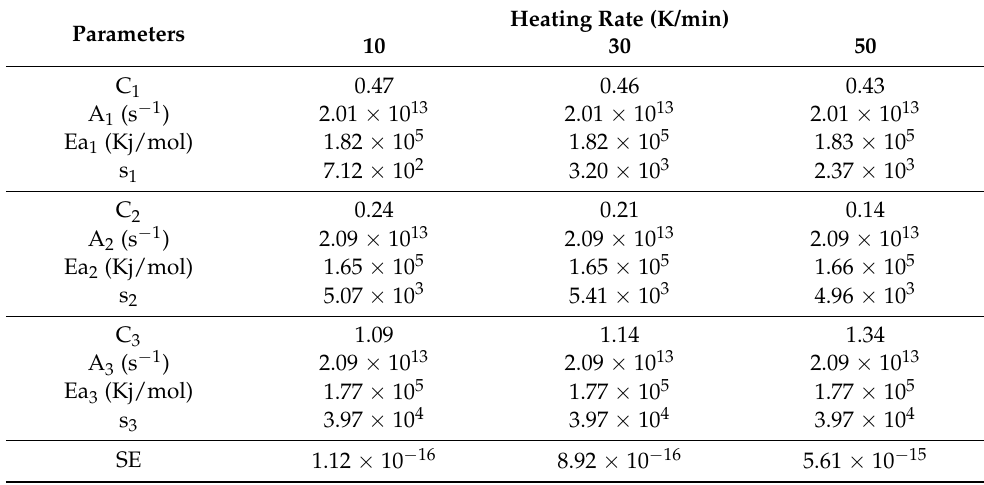
Table 8. Kinetics results DAEM model for the EFB + 1% Zn sample.